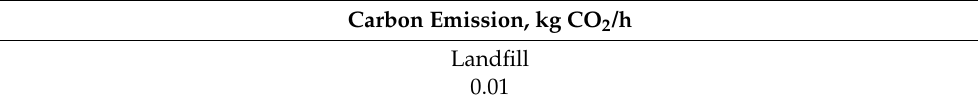
Table 13. Carbon emission from landfill.